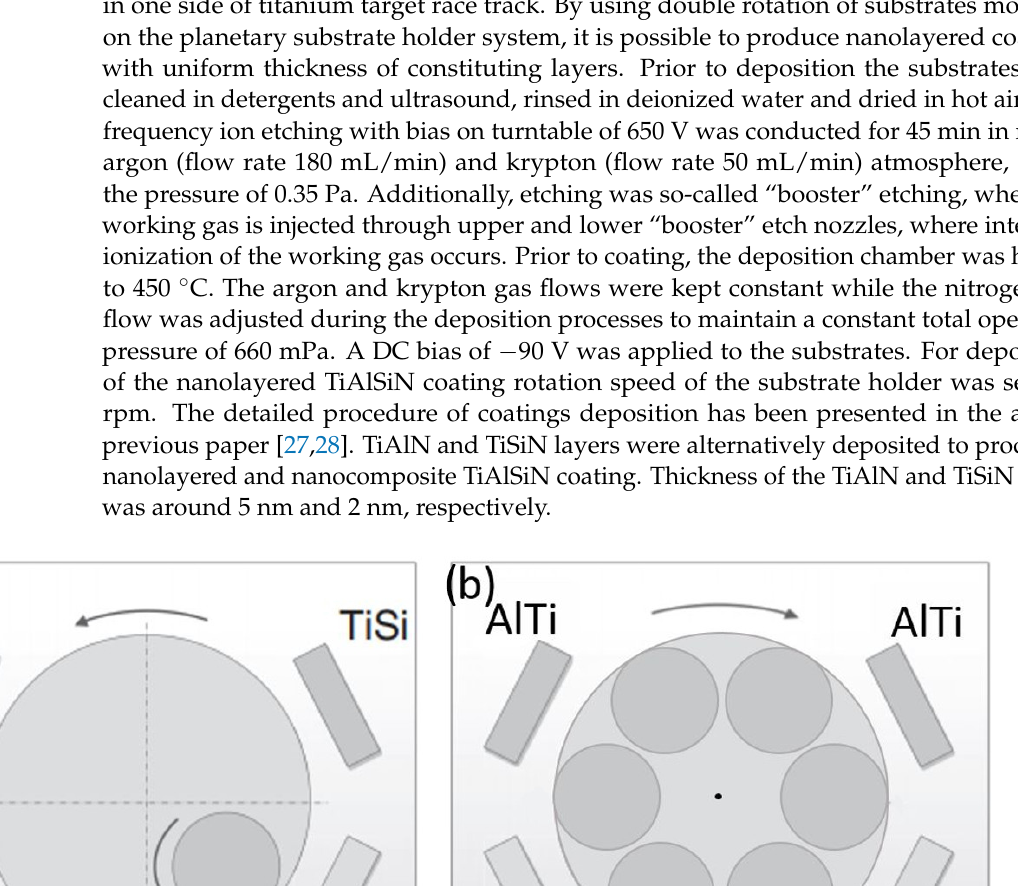
Figure 3. Configurations of the targets for the deposition of the nanolayer: ( a ) TiAlSiN and ( b ) TiN/AlTiN hard coatings.